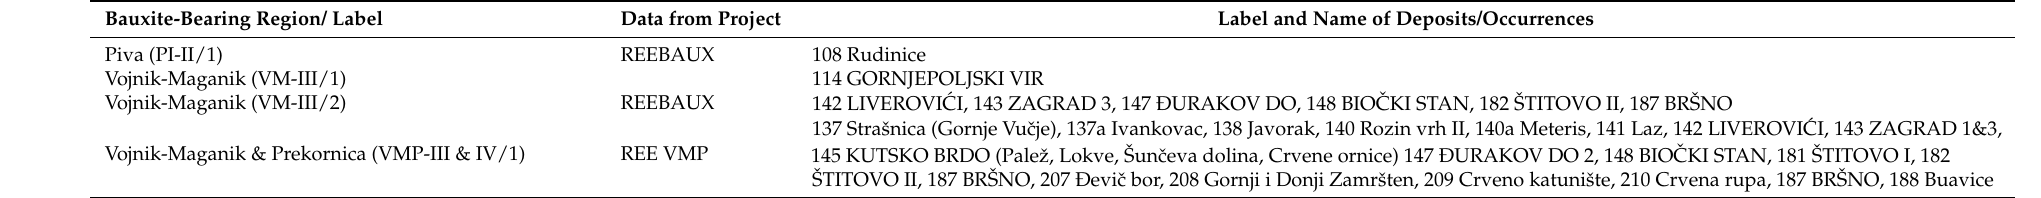
Table 2. Sampled bauxite deposits and